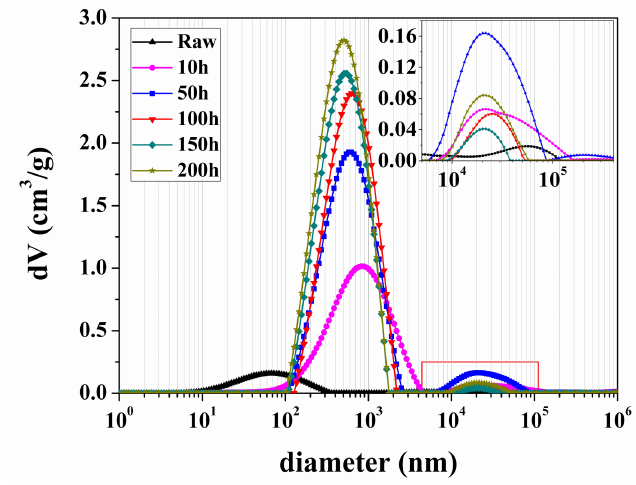
Figure 10. Pore size distribution (PSD) of the raw sample and spent samples extracted by sub-critical water at 350 ◦ C for different times. The inset figure is the local enlarged drawing of curves in the red